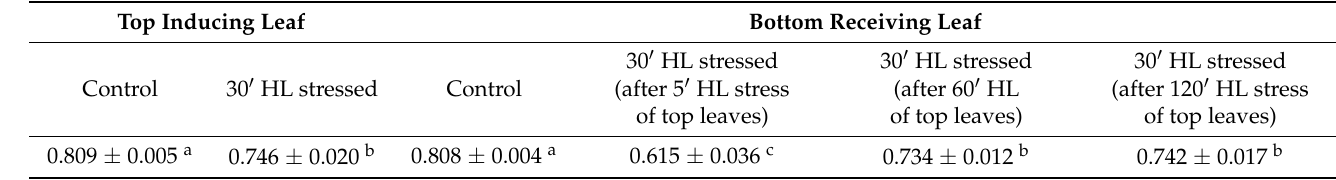
Table 1. Maximum photochemical efficiency (F v /F m ) in Top inducing leaves (Control and 30 (cid:48) HL stressed) and bottom receiving leaves (Control and 30 (cid:48) HL stressed). The bottom receiving leaves were subjected to 30 (cid:48) HL stress and measured after top inducing leaves were exposed to 5 (cid:48) , 60 (cid:48) , and 120 (cid:48) HL